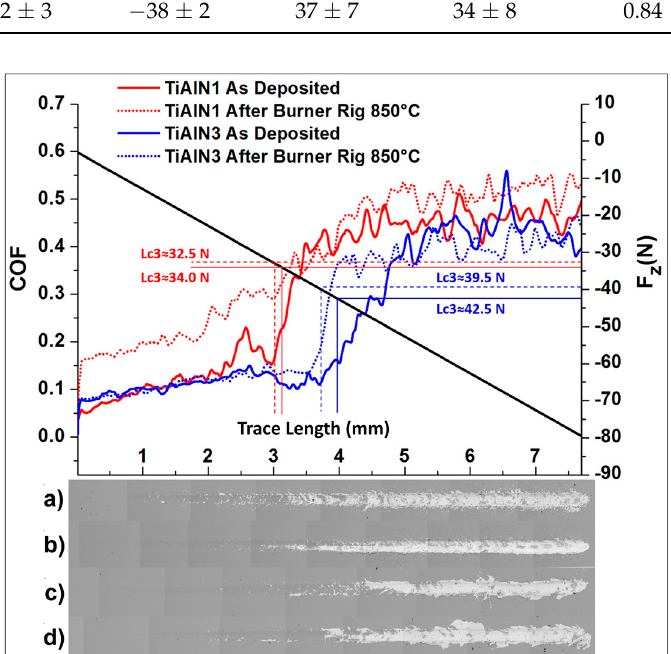
Figure 8. COF curves recorded during a single scratch test for the TiAlN1 sample and the TiAlN3 sample before and after burner rig (BR) tests (40 cycles up to 850 °C) are reported. SEM images of the associated scratch tracks are depicted too: ( a ) TiAlN1 as deposited; ( b ) TiAlN1 after BR; ( c ) TiAlN3 as deposited; and ( d ) TiAlN3 after BR. As an example, evaluated Lc3s are compared.